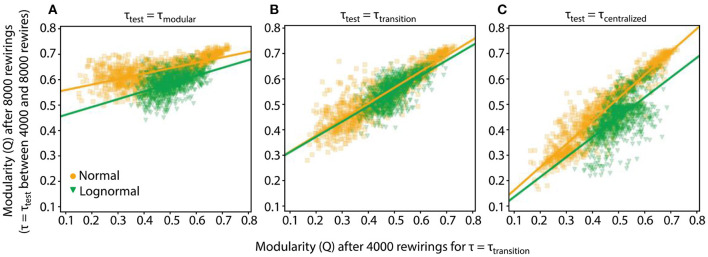
Robustness and specificity of the rewiring process depend on the value of τtest. The Q values of networks after 4,000 and 8,000 rewirings along with their linear fits are shown. For the first 4,000 rewirings τtransition (τnormal = 4.15, τlognormal = 5.5) was used, for the subsequent 4,000 rewirings τtest. We collect data from 1,000 rewiring instantiations of a condition. In all cases prandom = 0.2. (A) τtest = τmodular (τnormal = 3, τlognormal = 4.5). (B) τtest = τmodular. (C) τtest = τcentralized (τnormal = 5, τlognormal = 7).